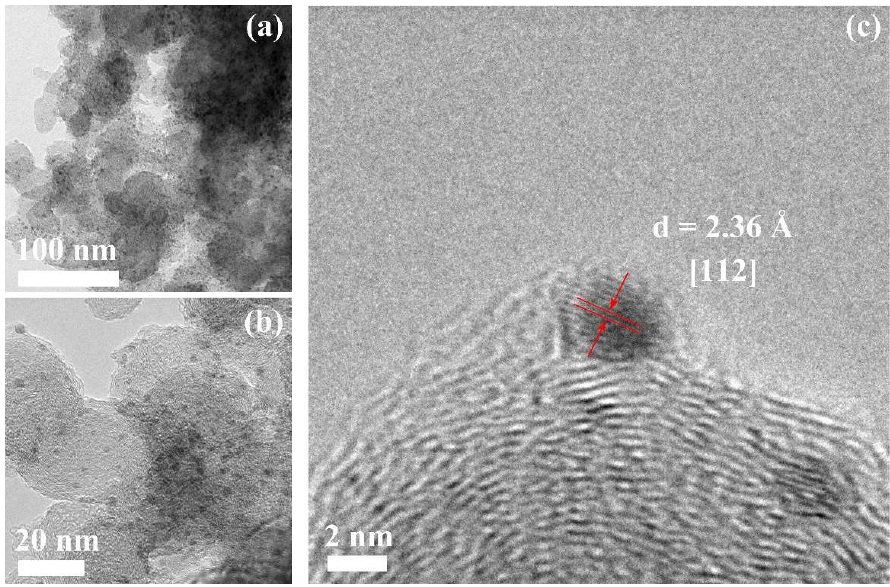
Figure 2. ( a , b ) TEM images and ( c ) HRTEM image of Ru 2 P-BM-C.